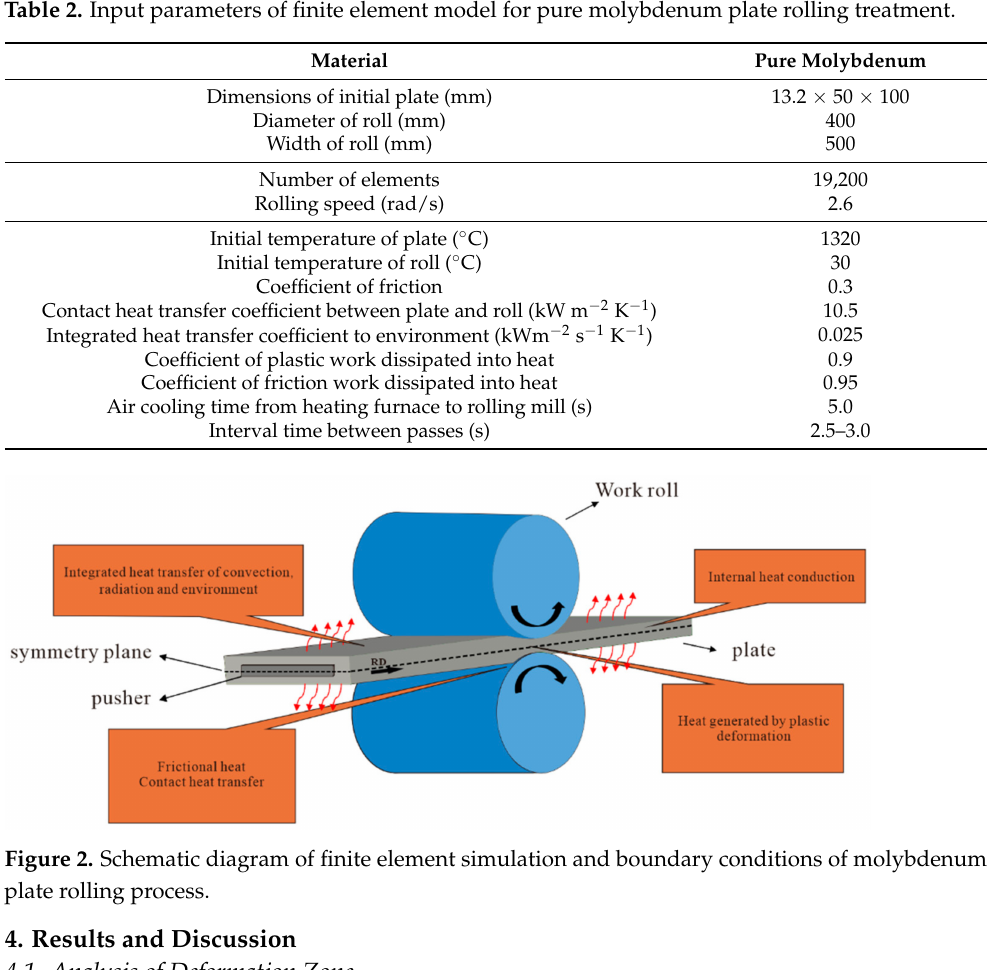
Table 2. Input parameters of finite element model for pure molybdenum plate rolling treatment.